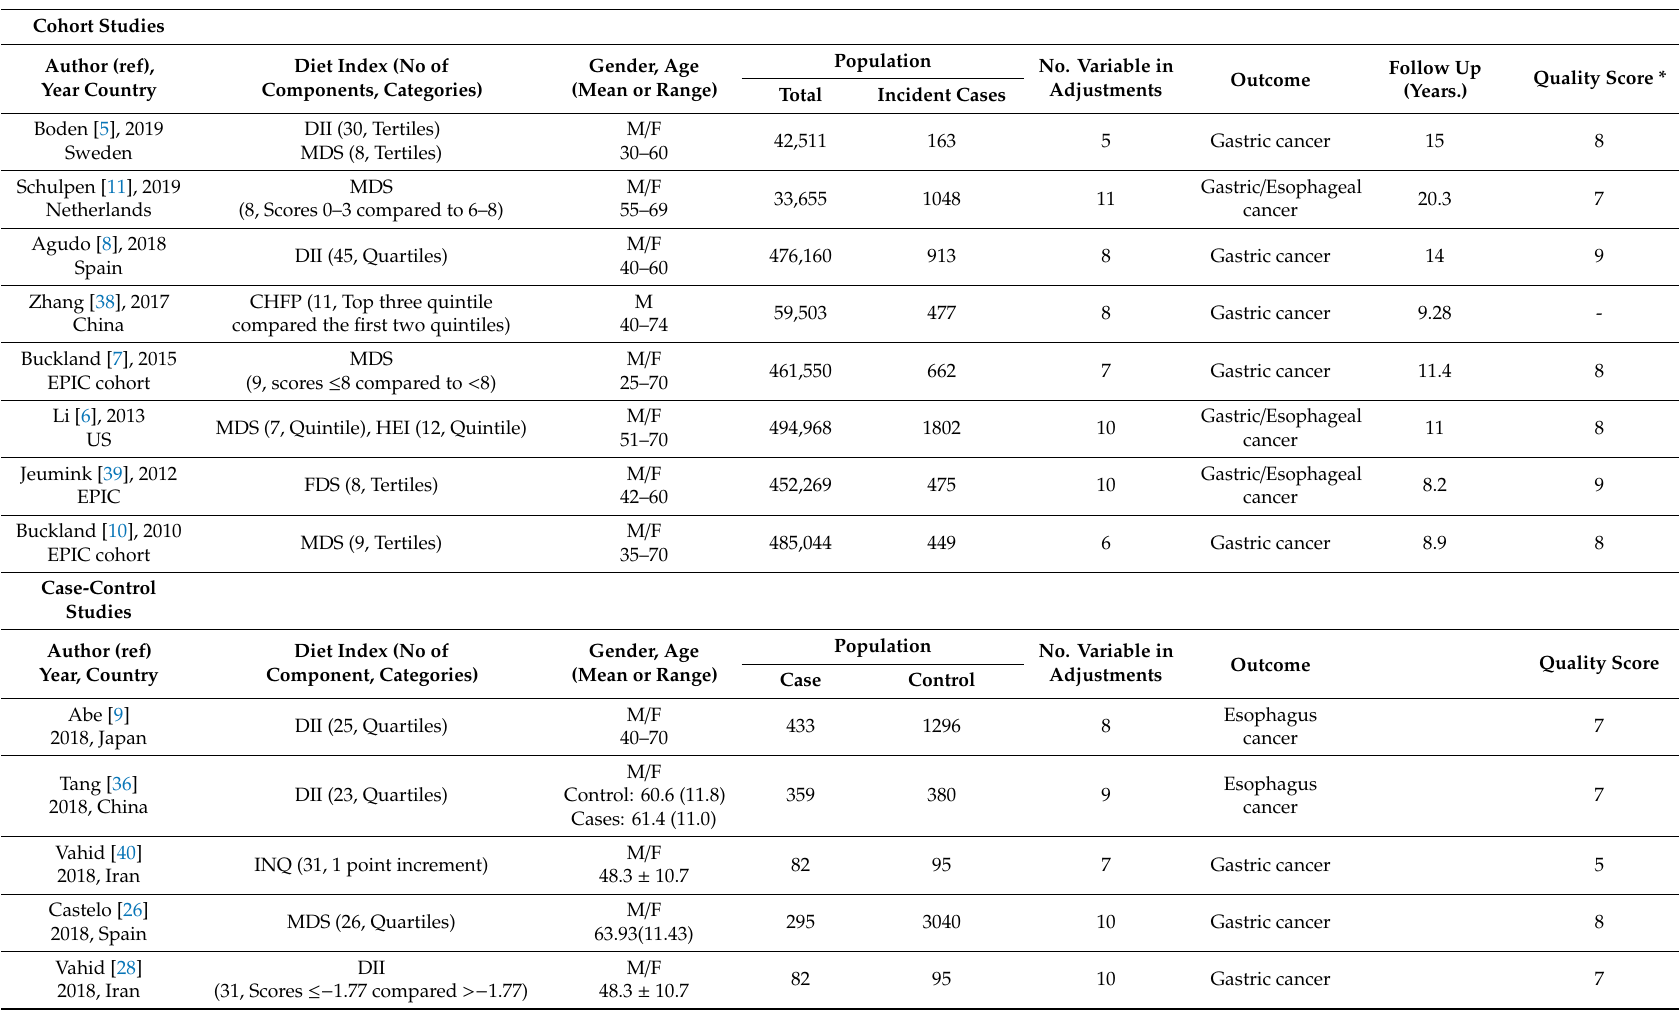
Table 1. General characteristics of included studies in the systematic review and meta-analysis of diet quality quantified by dietary indices and risk for UGI